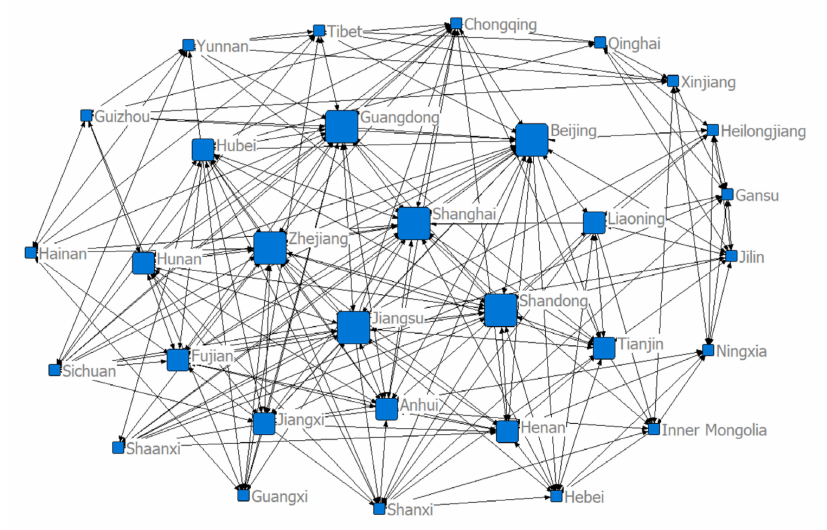
Figure 6. Structure of the spatial correlation network of health resource agglomeration capacities in China in